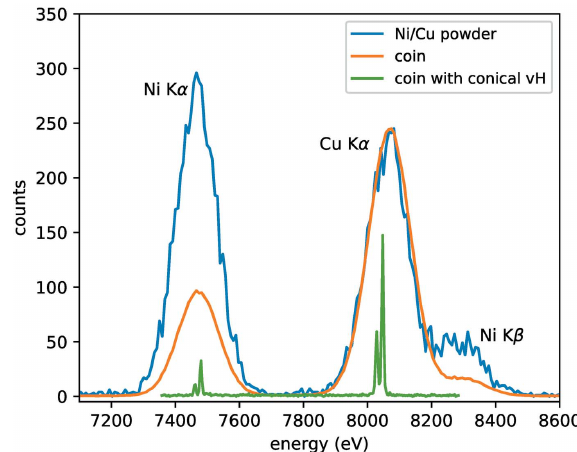
Figure 4 Comparison of K (cid:2) emission signals recorded by an energy-resolving solid state detector (Amptek SDD; mixed metallic powders: blue curve; inner part of a 200 HUF coin: orange) as well as a wavelength-resolving conical von Ha´mos spectrometer (200 HUF coin inner part: green).